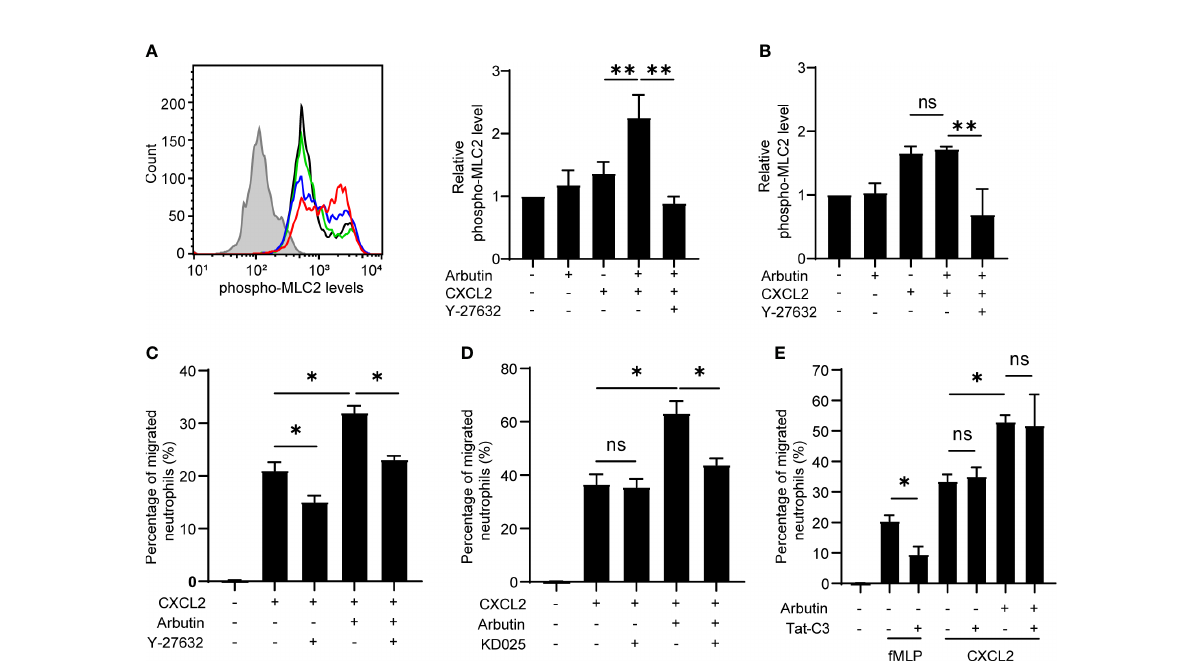
FIGURE 5 The ROCK – MLC2 pathway is involved in arbutin-mediated enhancement of CXCL2-stimulated neutrophil migration. (A) Left panel: FACS histograms of phosphorylated MLC2 expression levels in bone marrow (BM)-derived neutrophils from wild-type C57BL/6 mice. Neutrophils were untreated (black line) or incubated with CXCL2 alone (blue line), arbutin (green line), or both arbutin and CXCL2 (red line), Gray histogram shows control cells (anti-phospho-MLC2 pAb omitted). Right panel: Quanti fi cation of phosphorylated MLC2 expression (median fl uorescence intensity) in the treated cells. Cells were also analyzed after stimulation with CXCL2 in the presence of Y-27632. Data are presented as the mean ±SD of three to fi ve independent experiments. ** p < 0.01 by Student ’ s t test. (B) Quanti fi cation of phosphorylated MLC2 expression (median fl uorescence intensity) in BM-derived neutrophils from Tas2r126/135/143 − / − mice after treatment with arbutin and CXCL2. Data are presented as the mean ±SD of three to six independent experiments. ** p < 0.01 by Student ’ s t test. (C, D) Transwell migration assays of BM-derived neutrophils from Tas2r126/135/143 +/+ mice after pretreatment with arbutin and either Y-27632 (C) or KD025 (D) (both ROCK inhibitors) for 30 min followed by stimulation with CXCL2. Data are presented as the mean ± SD of triplicates from one experiment and are representative of three independent experiments. * p < 0.05 by Student ’ s t test. (E) Transwell migration assay of BM-derived neutrophils from Tas2r126/135/143 +/+ mice after pretreatment with arbutin and/or the RhoA inhibitor Tat-C3 followed by stimulation with fMLP or CXCL2. Data are presented as the mean ± SD of triplicates from one experiment and are representative of three independent experiments. ns, not signi fi cant; * p < 0.05 by Student ’ s t